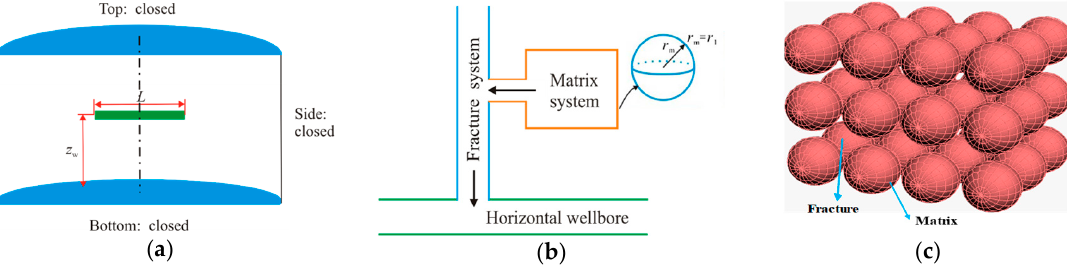
Figure 1. Description of the dual-porosity model in this paper: ( a ) horizontal well-scheme in formation; ( b ) dual-porosity model flow scheme; ( c ) dual-porosity model with spherical matrix.